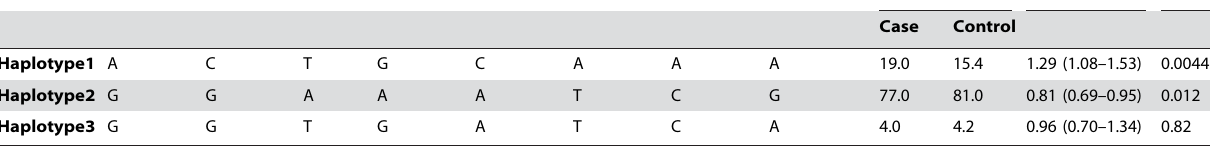
Table 6. MECP2 haplotype frequencies in the European-derived female SLE patients and